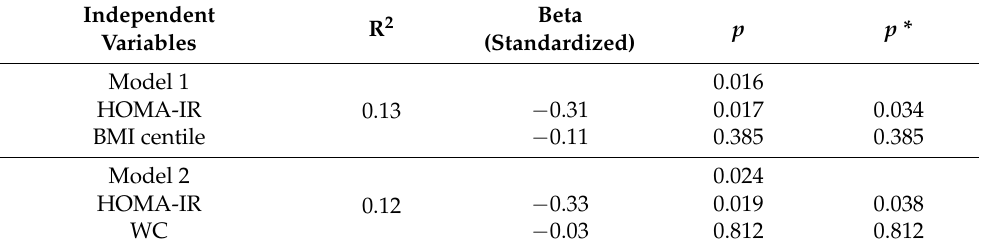
Table 4. The multiple linear regression analysis between CTX-1 and HOMA-IR in models including BMI centile and WC in